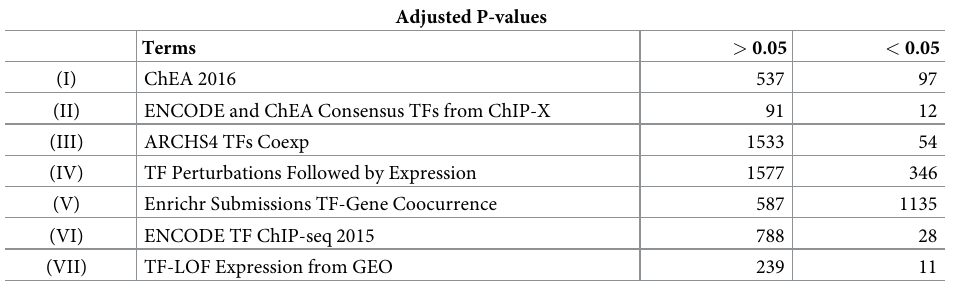
Table 3. Number of transcription factors (TFs) associated with adjusted P -values less than 0.05 in various TF- related Enrichr categories. See S2 Table for the full list.